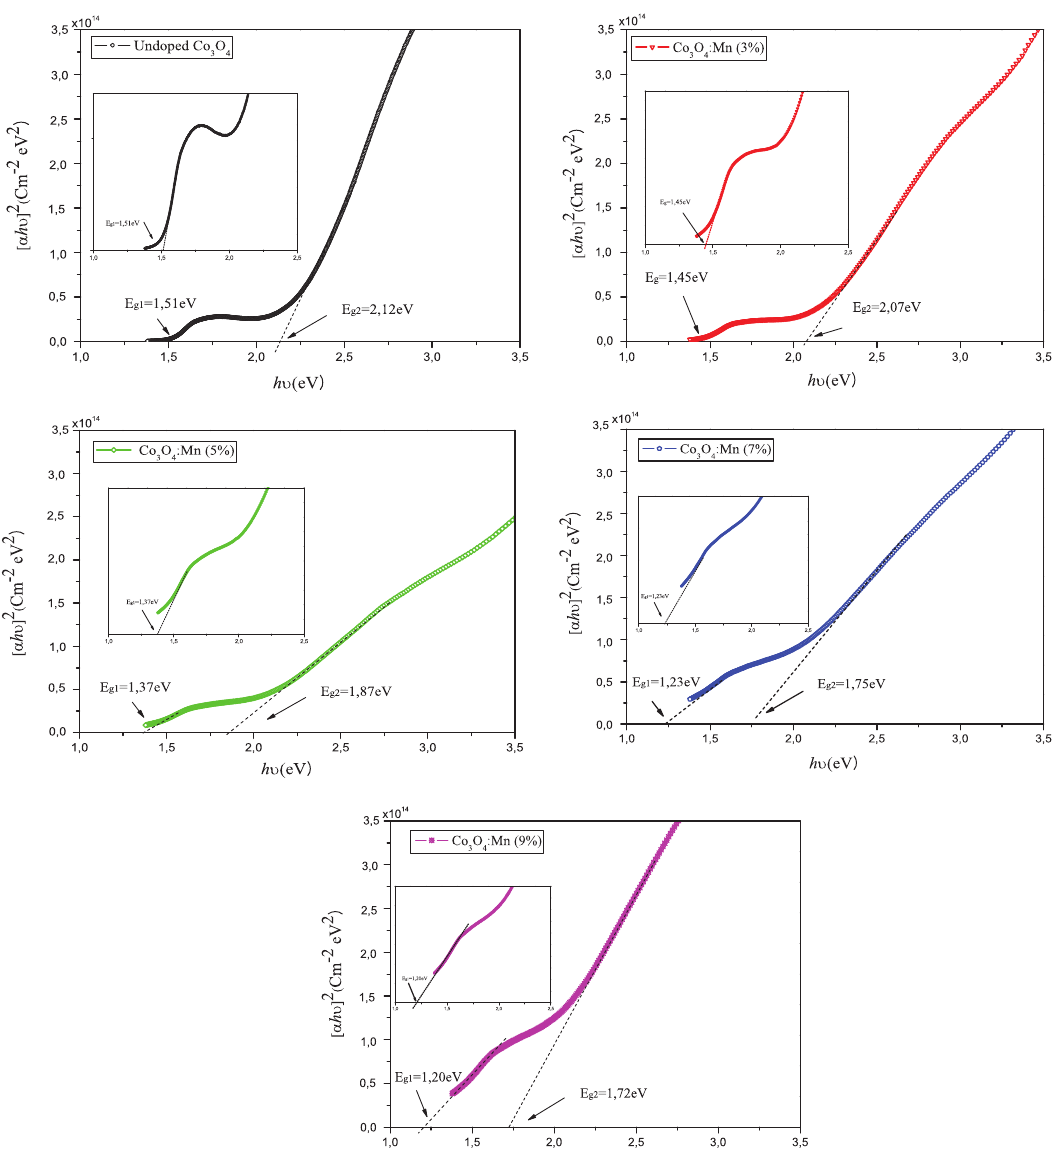
Figure 3: Tauc plots of Mn-doped Co 3 O 4